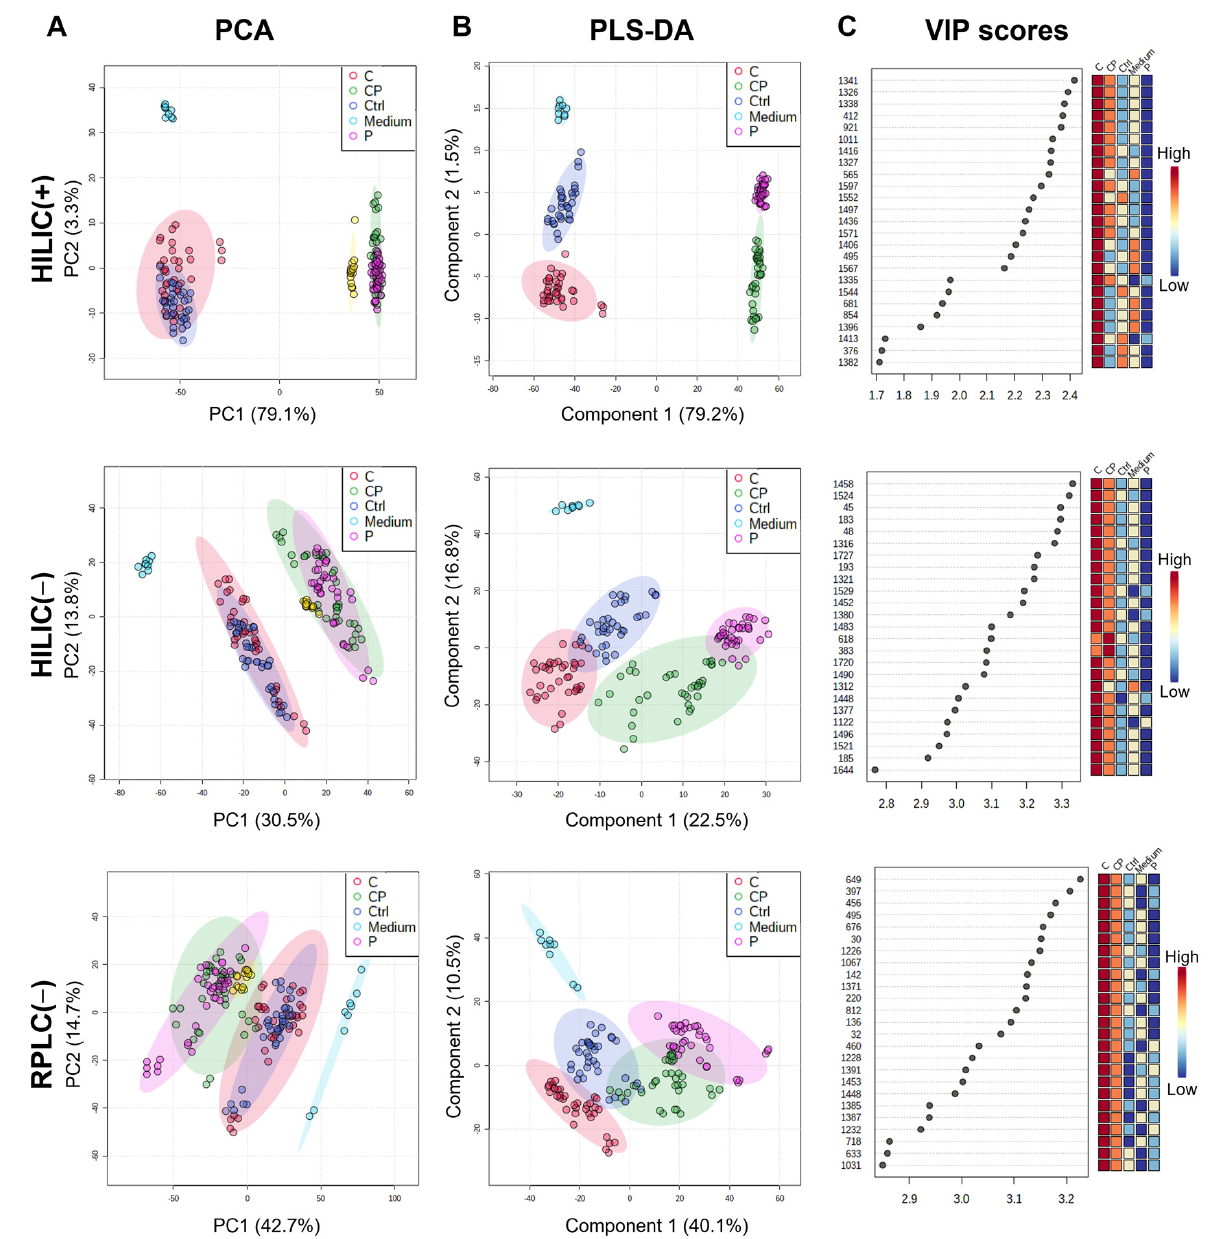
Figure 3. Untargeted metabolic footprints can distinguish between treatment groups in two high- grade serous ovarian carcinoma (OvC) patient-derived explant (PDE) cultures. Multivariate data analysis performed using: ( A ) principal component analysis (PCA), ( B ) partial least-squares discrimi- nant analysis (PLS-DA) for subsequent identification of corresponding important features identified by ( C ) variable importance in projection (VIP) score in PLS-DA (colored boxes on the right indicate the relative concentrations of the corresponding metabolite in each condition). The LC-MS-based metabolic footprinting performed using HILIC and RPLC columns, in positive (+) and negative ( − ) ionization modes; N = 2 OvC cases (OvC5 and OvC8), with 3 culture replicates per condition,